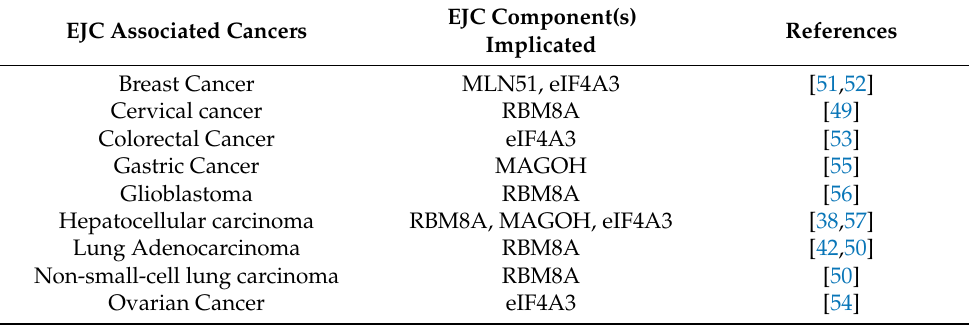
Table 3. EJC-associated cancers with implicated EJC components and